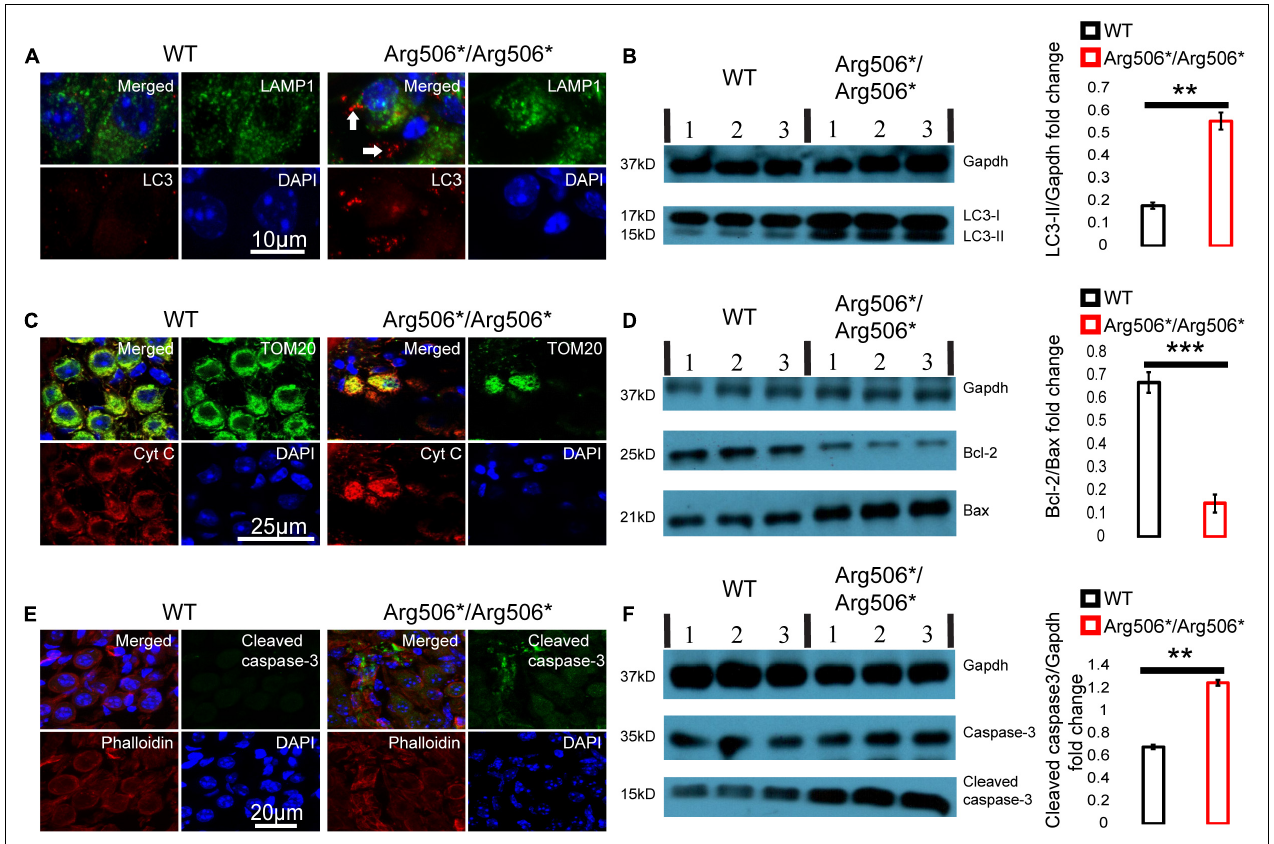
FIGURE 3 | Abnormal autophagy and apoptosis activated by cytochrome C in the spiral ganglion neurons (SGNs) of Atp6v1b2 Arg 506 ∗ / Arg 506 ∗ mice. (A) Representative images of immunostaining showed that autophagosomes labeled with LC3 (white arrows) were present in large numbers as dots in the SGNs of Atp6v1b2 Arg 506 ∗ / Arg 506 ∗ mice. (B) Left: Western blotting results showed that LC3-II increased in the cochlea of Atp6v1b2 Arg 506 ∗ / Arg 506 ∗ mice compared with that in the cochlea of WT mice. LC3-II can be used to estimate the extent of autophagy. Right: Statistical results of gray value for western blotting. The ratio of LC3-II/Gapdh in the cochlea of Atp6v1b2 Arg 506 ∗ / Arg 506 ∗ mice was significantly higher than that in the cochlea of WT mice (** denotes P < 0.01 by t -test; n = 3 for each group). (C) The release of cytochrome C from the mitochondria into the cytosol of the SGNs in Atp6v1b2 Arg 506 ∗ / Arg 506 ∗ mice is shown. Mitochondria are labeled with TOM20 (green). Cytochrome C is labeled as red. In WT mice, cytochrome C remains in the mitochondria and no red signal was observed in the cytosol of the SGNs. In Atp6v1b2 Arg 506 ∗ / Arg 506 ∗ mice, cytochrome C was observed both in the mitochondria and the cytosol of the SGNs, indicating its release from mitochondria. (D) Left: Western blotting results showed that in the cochlea of Atp6v1b2 Arg 506 ∗ / Arg 506 ∗ mice, Bcl-2 decreased significantly compared with that in the cochlea of WT mice. Right: Statistical results of gray value for western blotting (*** denotes P < 0.001 by t -test; n = 3 for each group). (E) More pronounced positive signal for cleaved caspase-3 in the region of SGNs of Atp6v1b2 Arg 506 ∗ / Arg 506 ∗ mice was identified. Phalloidin is a high-affinity filamentous actin (F-actin) marker, which is used to mark the cytoskeleton. (F) Left: Western blotting results showed that cleaved caspase-3 increased in the cochlea of Atp6v1b2 Arg 506 ∗ / Arg 506 ∗ mice compared with that in the cochlea of WT mice. Right: Statistical results of gray value for western blotting. The ratio of cleaved caspase-3/Gapdh in the cochlea of Atp6v1b2 Arg 506 ∗ / Arg 506 ∗ mice was significantly higher than that in the cochlea of WT mice. ** denotes P < 0.01. n = 3 for each group. Data are described as mean ± SEM (standard error of mean). Cyt C, cytochrome